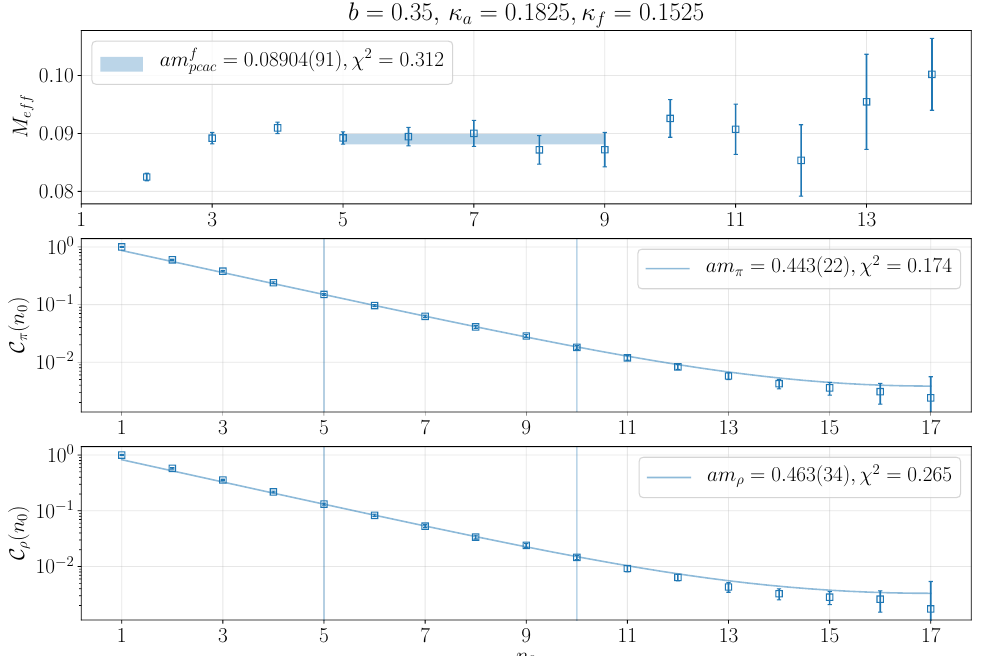
Figure 8. Stack plot of the correlators in this analysis for one example case. The first one shows the signal for am f as an effective mass. The blue band is the result of the fit, the length corresponds pcac to the time slices used to fit the mass, while the width correspond to the error. The second and the third, displays the pion and the rho correlator signal, respectively. The blue line is the result of the fit performed in the region between the vertical